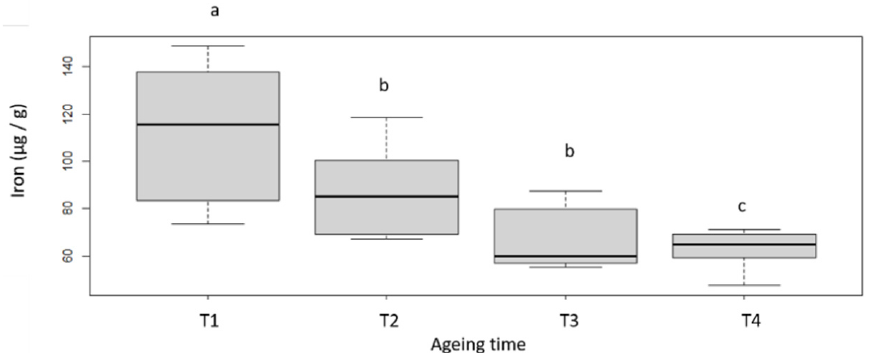
Figure 4. Iron content of the different samples as a function of ageing time. T1, T2, T3 and T4 correspond with the different ageing length (respectively 7, 16, 35 and 60 days). Box-plot explanation: the central value represents the median, the edges of the rectangle are the quartiles and the extremities are calculated using 1.5 times the interquartile range. a, b, c: significant differences ( p < 0.05). the shear force and the compression measurements (at 20 and 80% of the sample